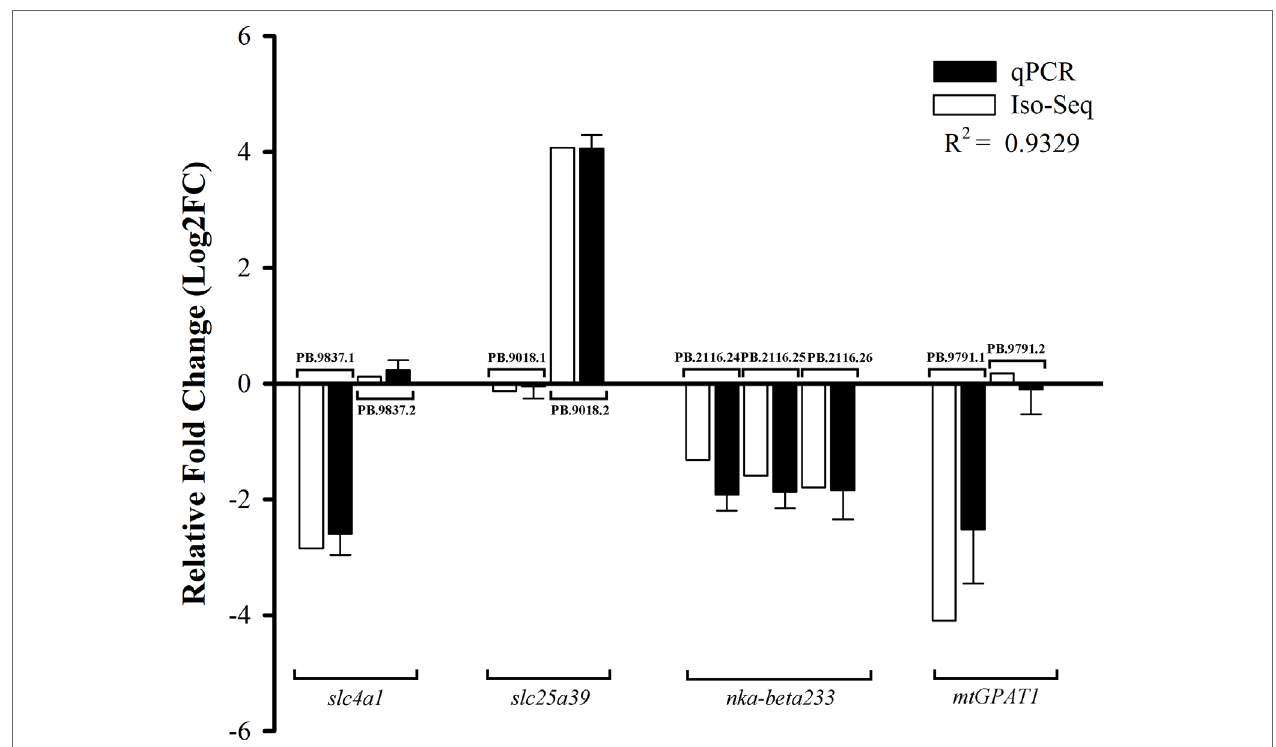
FIgURe 7 | qPCR validation of DETs. The expression levels were showed as the log 2 fold change in SW relative to FW group. Gene abbreviations were as followed: slc4a1 , solute carrier family 4a1 ; slc25a39 , solute carrier family 25 member 39 ; nka-beta233 , sodium/potassium-transporting ATPase subunit beta-233 ; mtGPAT1 , glycerol-3-phosphate acyltransferase 1, mitochondrial